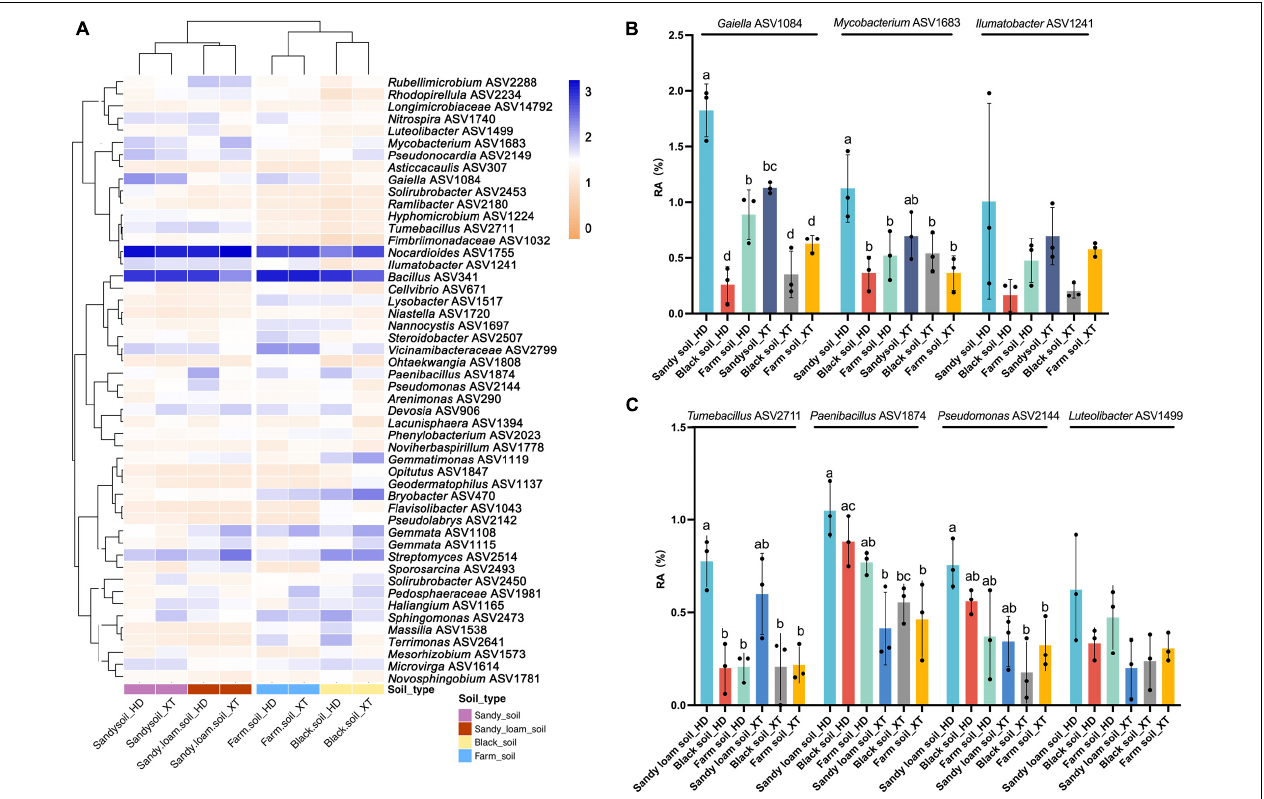
FIGURE 5 | Top 50 ASVs of 50 DPS in all samples. (A) A heat map and hierarchical clustering show the average relative abundance of the top 50 ASVs of 50 DPS samples. (B) Relative abundances of Gaiella ASV1084, Mycobacterium ASV1683, and Ilumatobacter ASV1241 in XT and HD in sandy soil, black soil and farm soil at 50 DPS. (C) Relative abundances of Tumebacillus ASV2711, Paenibacillus ASV1874, Pseudomonas ASV2144, and Luteolibacter ASV1499 of XT and HD in sandy loam soil, black soil and farm soil at 50 DPS. Data are the means of three replicates, and error bars indicate standard deviations ( p < 0.05); significance among different groups is indicated by P -values (ANOVA, Turkey HSD). Letters represent the results of Tukey’s